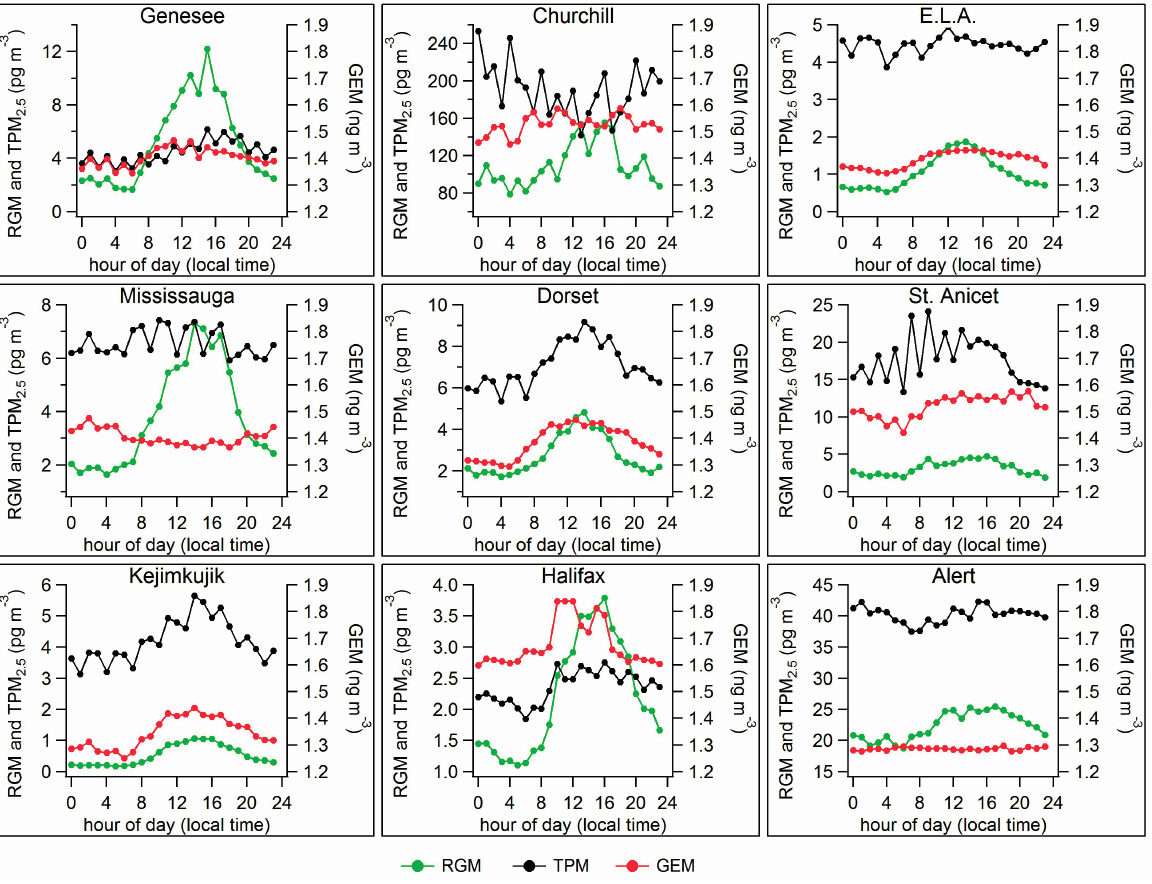
Figure 6. Diel cycles in concentrations of GEM, RGM and TPM for each hour) at nine sites. Axis scales for RGM and TPM